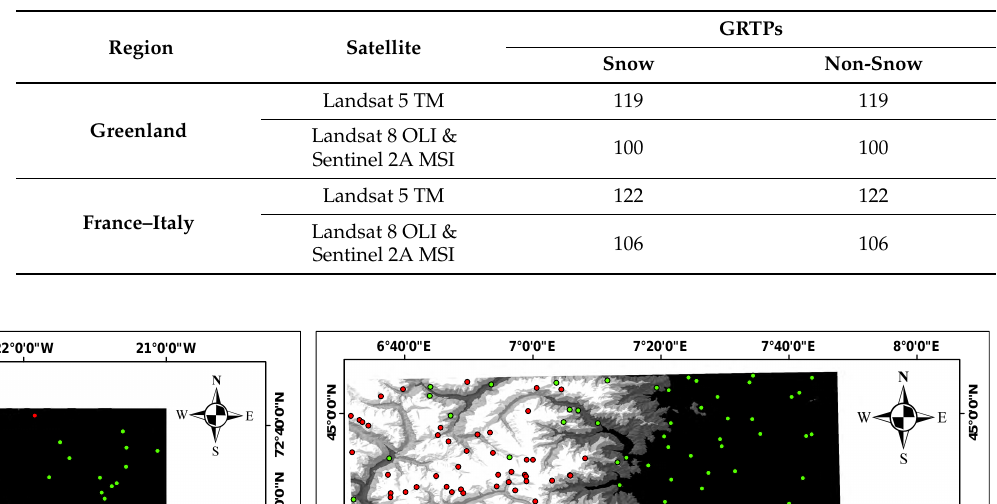
Table 8. Numbers of designated snow and non-snow Ground Reference Test Pixels (GRTPs) over the Greenland and France–Italy regions.